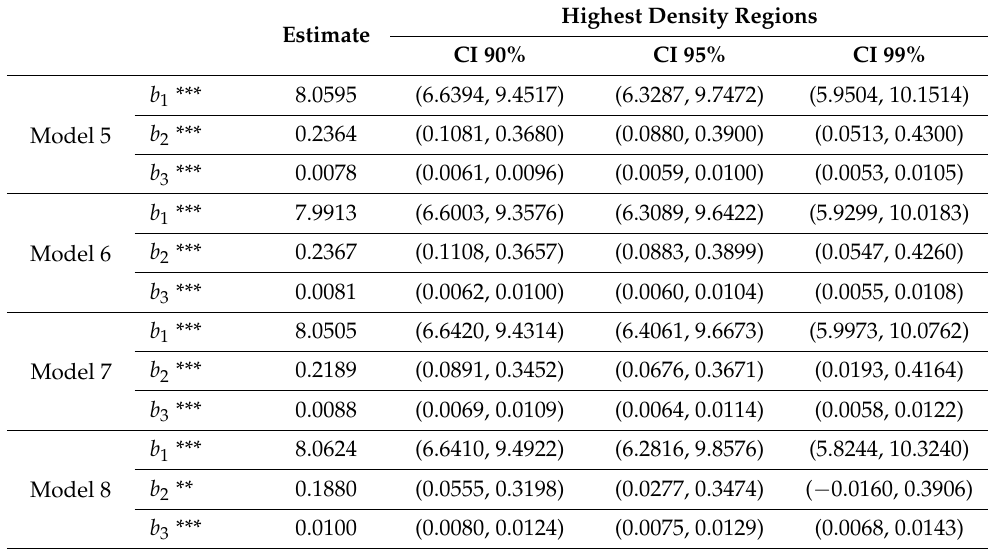
Table 5. Results for Model 5 to Model 8 (data from 1959 to 1989).